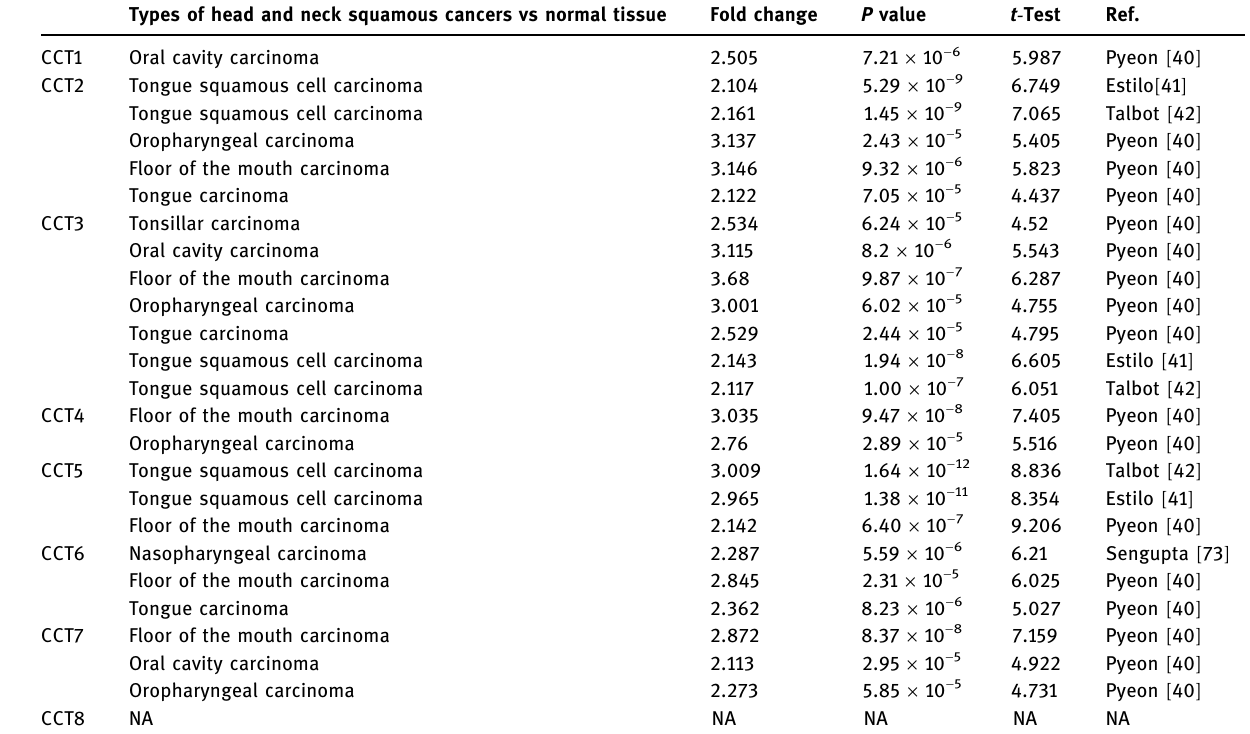
Table 1: The signi fi cant changes in CCTs expression in mRNA transcriptional level between di ff erent types of head and neck squamous cancers and normal tissues ( ONCOMINE database ) Types of head and neck squamous cancers vs normal tissue